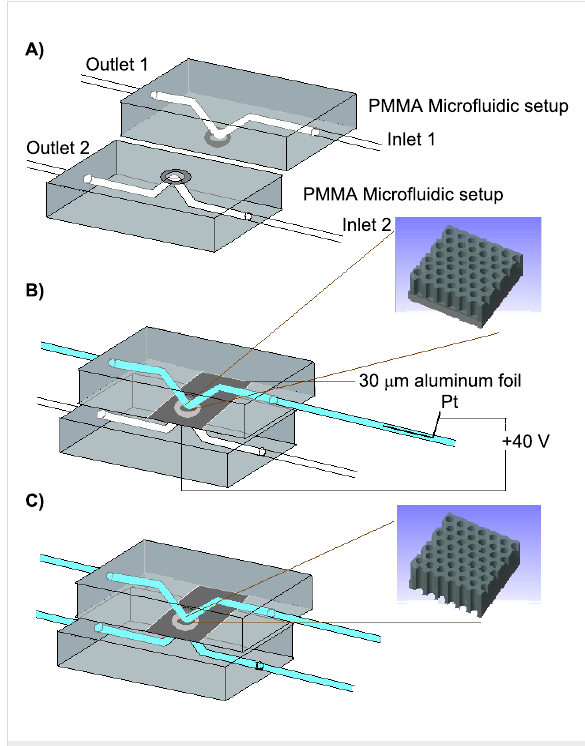
Figure 1: A) Schematics of the flow cell design for microfluidic anodization. B) An aluminum substrate is anodized at 40 V under